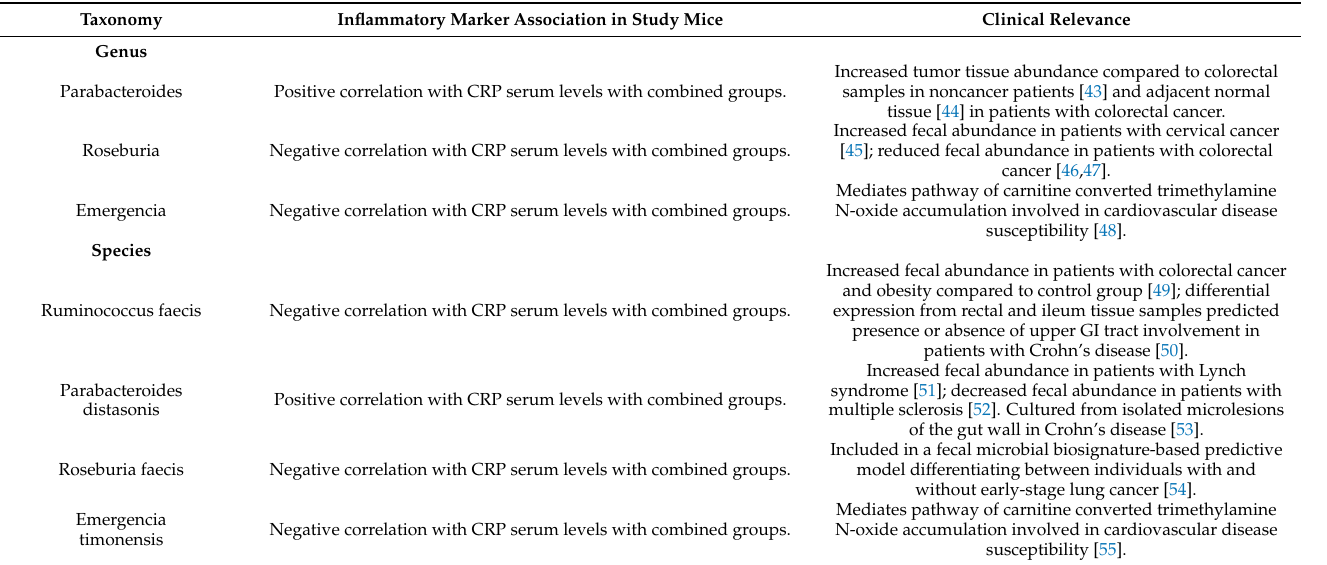
Figure 8. Correlation between C-reactive protein (CRP) serum level and bacterial diversity indices. ( a ) CRP and Shannon diversity index, ( b ) CRP and Simpson diversity index. Table 1. Key bacteria and clinical associations.